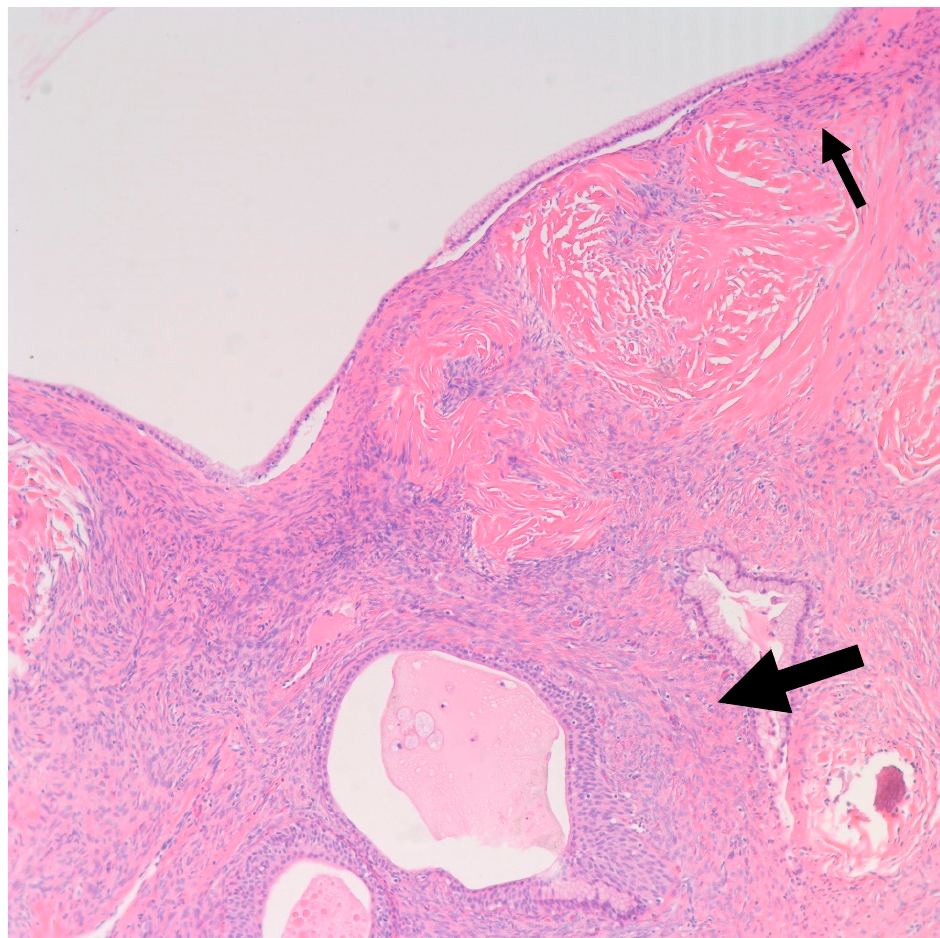
Figure 8. Shown is a 100× magnification H&E microscopic image of mucinous metaplasia of a nest of Brenner tumor (Large arrow) with an adjacent mucinous cystadenoma (Small arrow) (100× magnification).